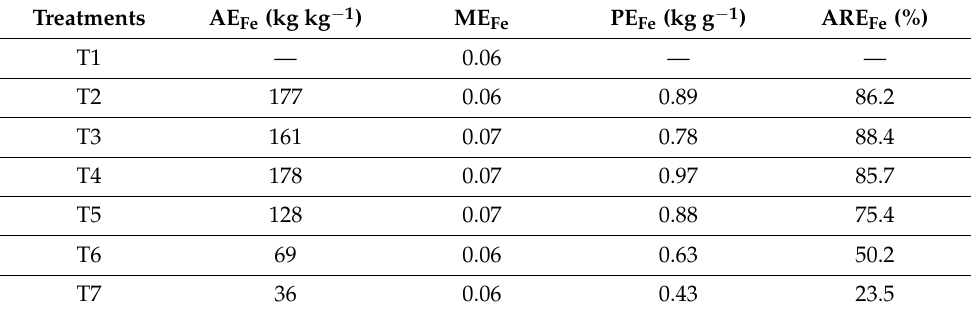
Table 5. Impact of foliar application of FeSO 4 · 7H 2 O on Fe use efficiency indices of soybean.